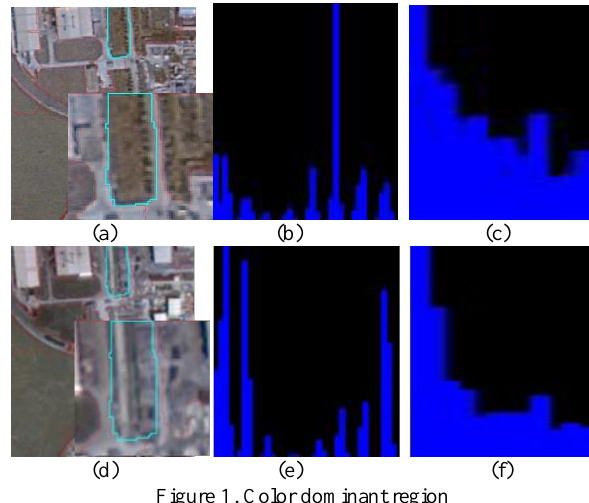
Figure 1. Color dominant region